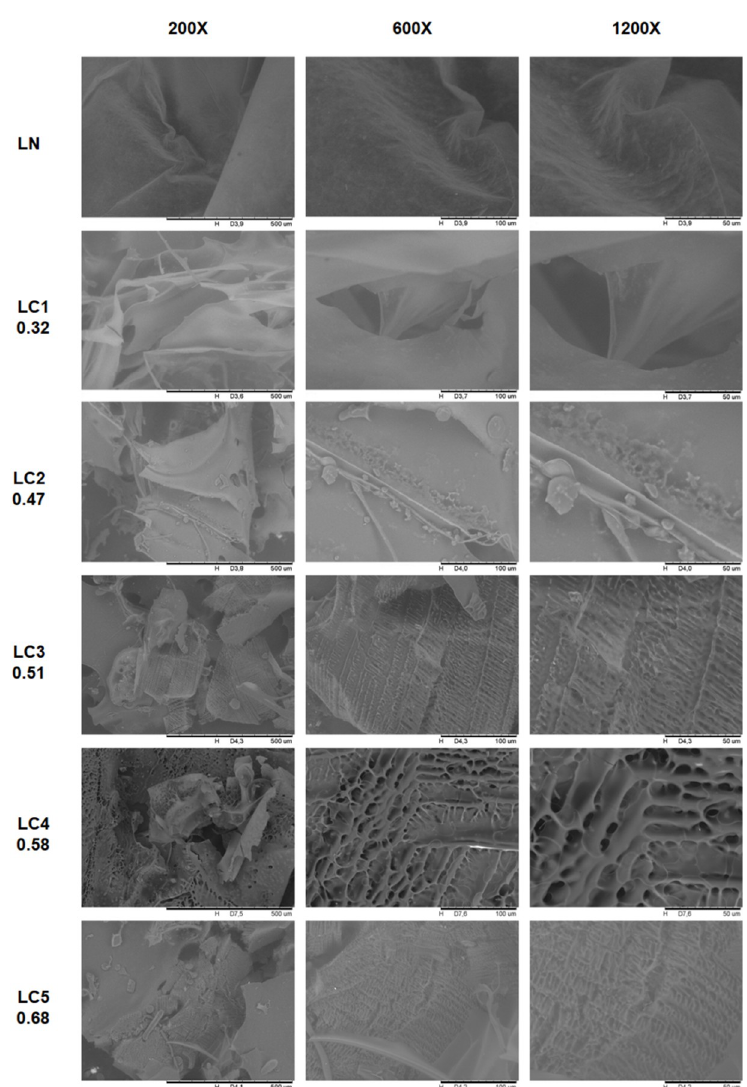
Figure 4. Micrographs (SEM) of LN and LC with different degrees of substitution 400X, 800X, and 1500X magnification.